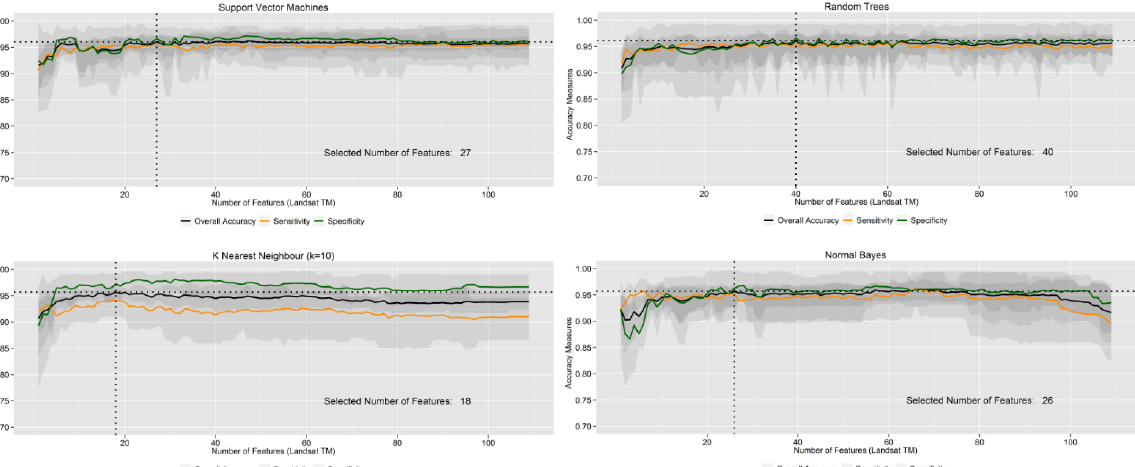
Figure 5. Influence of the size of the feature vector on the classification accuracy for TM. Mean and range of accuracy measures from the ten-fold cross-validation are shown for each